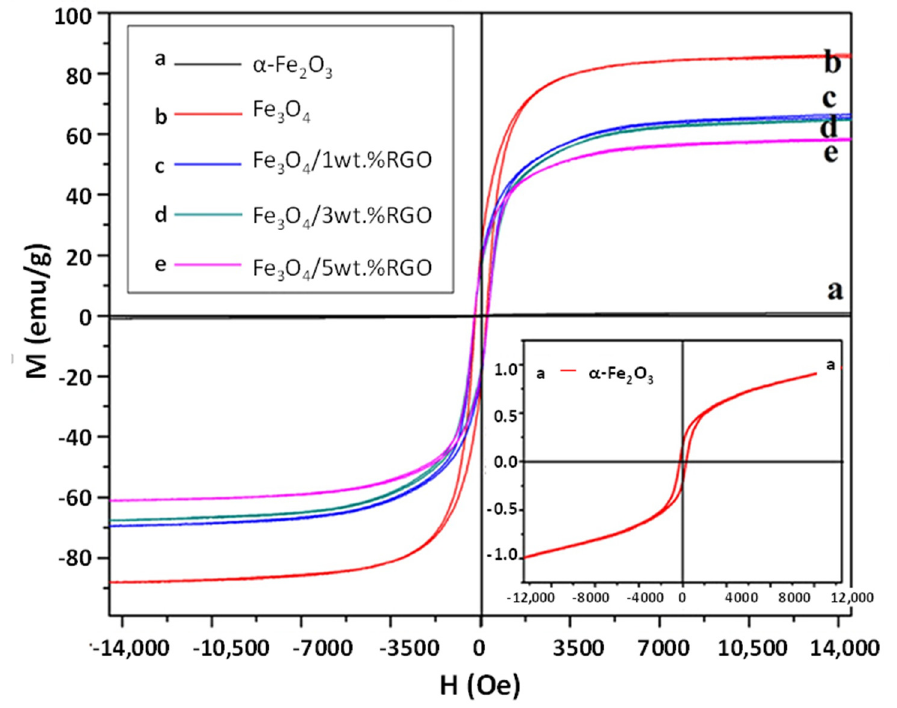
Figure 17. Fe 3 O 4 /G nanocomposites saturation magnetization values presented as hysteresis loops. Reprinted with permission from [172]. Copyright (2016) Creative Commons Attribution. Table 4. Summary of selected graphene-magnetic NPs photocatalysts.